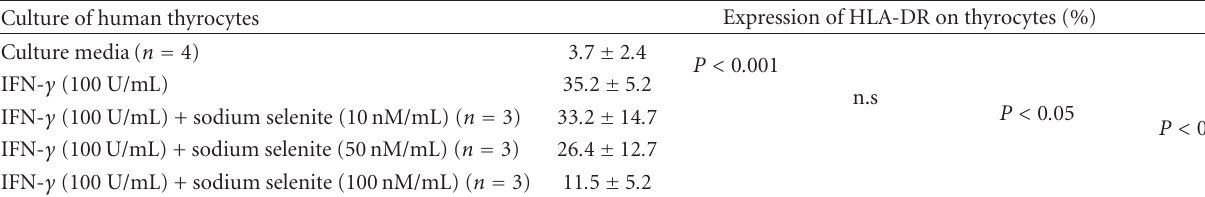
Table 1: Investigation of HLA-DR expression on thyrocytes induced by IFN- γ in the absence and presence of selenium. Figures in the table represent mean percentage DR positive human thyroid cells ± SD. All experiments were made in triplicate. ns. = not significant. Culture of human thyrocytes Expression of HLA-DR on thyrocytes